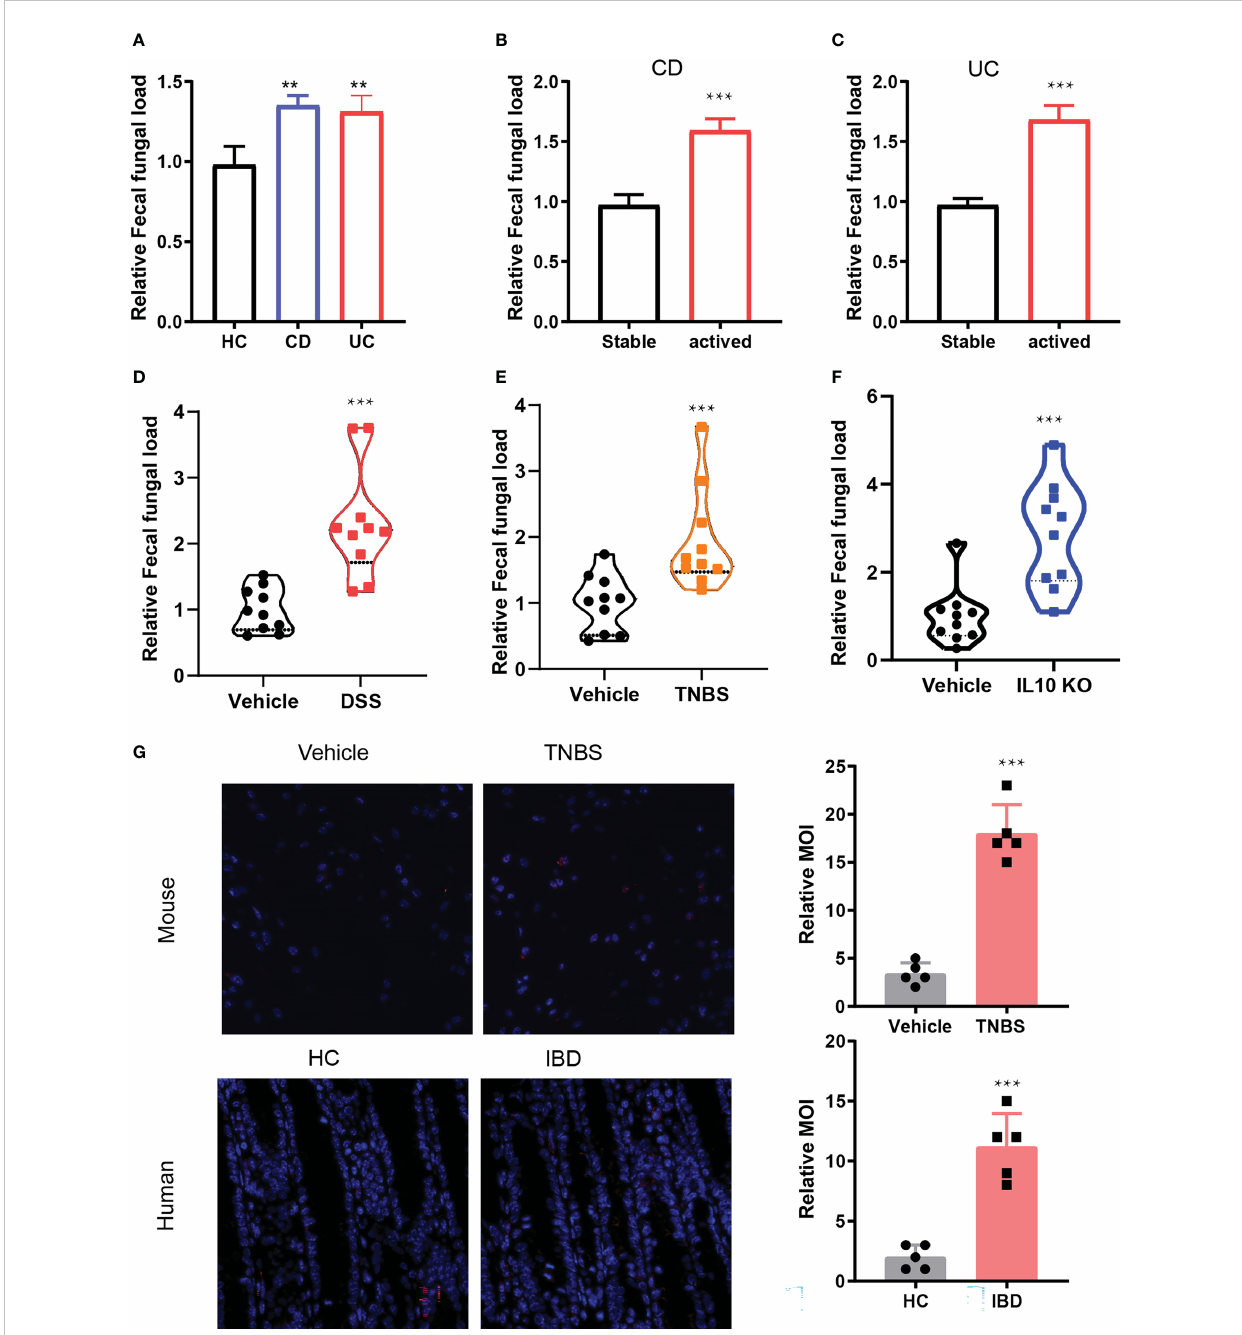
FIGURE 1 The amount of fungi increased in IBD. (A) . Fungal DNA in fecal samples from healthy control (HC), CD and UC patents by detecting 18S rRNA, n = 40. (B, C) . The amount of fungal DNA in the activate status of CD (B) and UC, n = 20 (D) . (E – G) : The relative fungal DNA in the control and IBD mice model including DSS induced IBD, n = 5. (E) , TNBS induced IBD, IL10 KO induced IBD. (H) In situ hybridization of fungi in the human and mice colon specimens. **P < 0.01, and ***P <